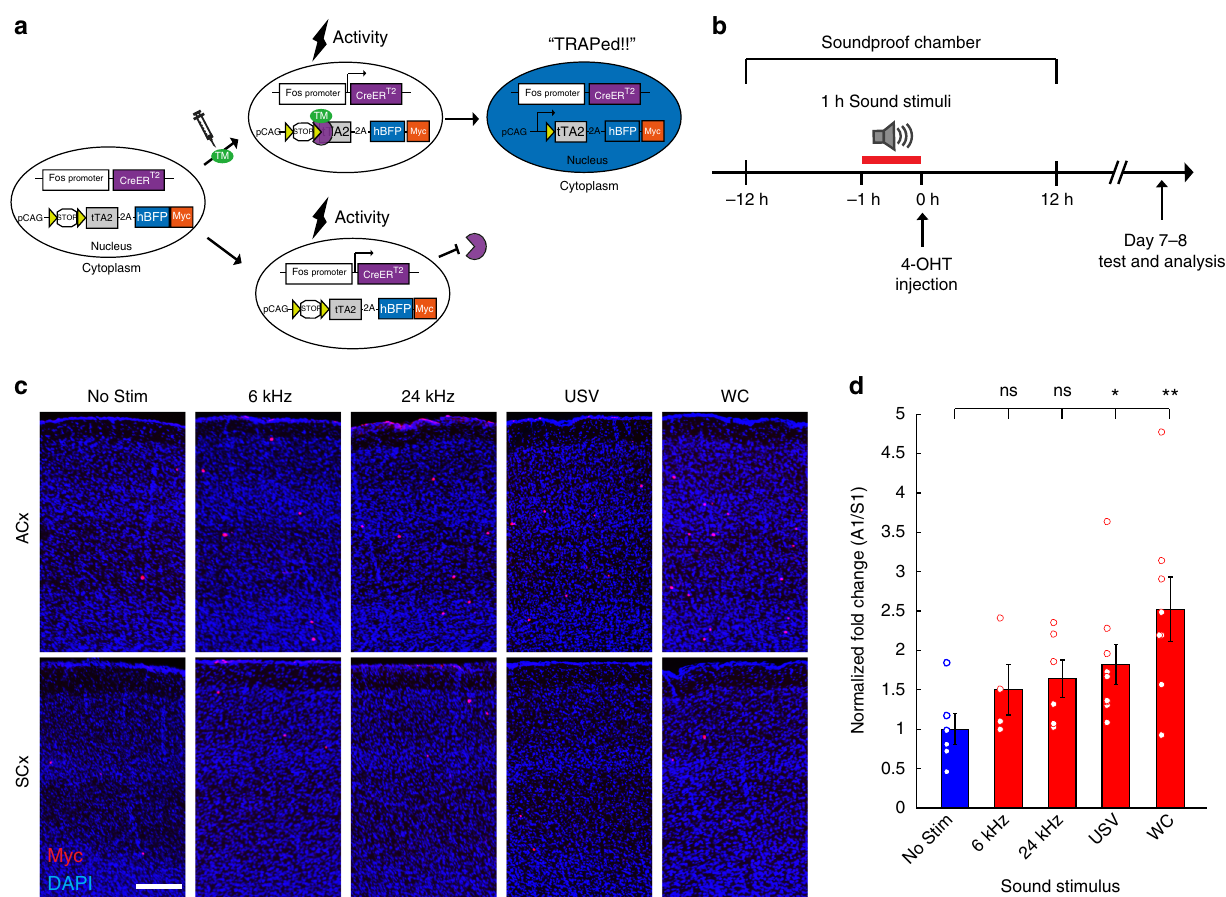
Fig. 1 A binary expression system to TRAP active neurons in A1 with natural sounds. a Schematic of the TRAPxTB system. Left: the double transgenic mouse expresses CreER T2 from the Fos promoter, and a second cassette allows expression of two effector genes, a histone-BFP-myc nuclear marker and a tetracycline-dependent transactivator (tTA2) in a Cre-dependent manner. Bottom: in the presence of activity but without tamoxifen (TM), CreER T2 is expressed but retained in the cytoplasm, and no recombination can occur. Top: in the presence of activity and TM, CreER T2 can enter the nucleus and induce recombination and expression of histone-BFP-Myc and tTA2 (right, “ TRAPed ” ). b Experimental protocol for TRAPing in A1. TRAPxTB mice were placed in a soundproof chamber, and were given an injection of 15 mg/kg 4-OHT after 1 h sound stimulation. After 7 – 8 days, mice were used for experiments. c Representative photomicrographs from the primary auditory (ACx, top rows) and somatosensory (SCx, bottom rows) cortices of mice stimulated with different sounds (indicated above images) and stained for myc. Scale bar, 200 μ m. d Quanti fi cation of the density of TRAPed cells in A1 relative to their density in S1 and normalized to the ‘ No Stim ’ condition (mean ± SEM; ‘ No Stim ’ N = 6 mice, ‘ 6 kHz ’ N = 4 mice; ‘ 24 kHz ’ N = 6 mice; ‘ USV ’ N = 9 mice; ‘ WC ’ N = 8 mice). USVs and WCs but not pure tone stimuli (6 kHz and 24 kHz) induced a signi fi cant increase in the number of the TRAPed neurons in A1 (* p < 0.05; ** p < 0.01; ns, not signi fi cant, post hoc Fisher ’ s LSD test after Kruskal – Wallis